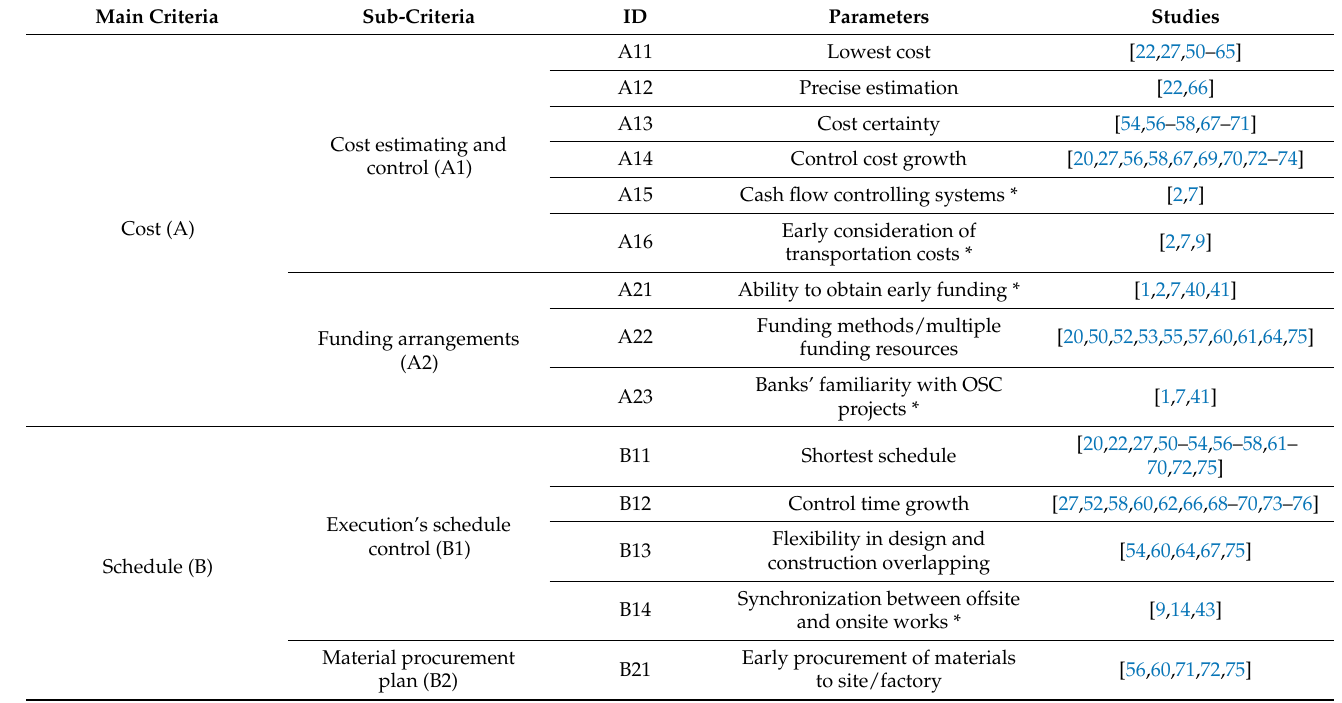
Table 1. The project delivery system selection